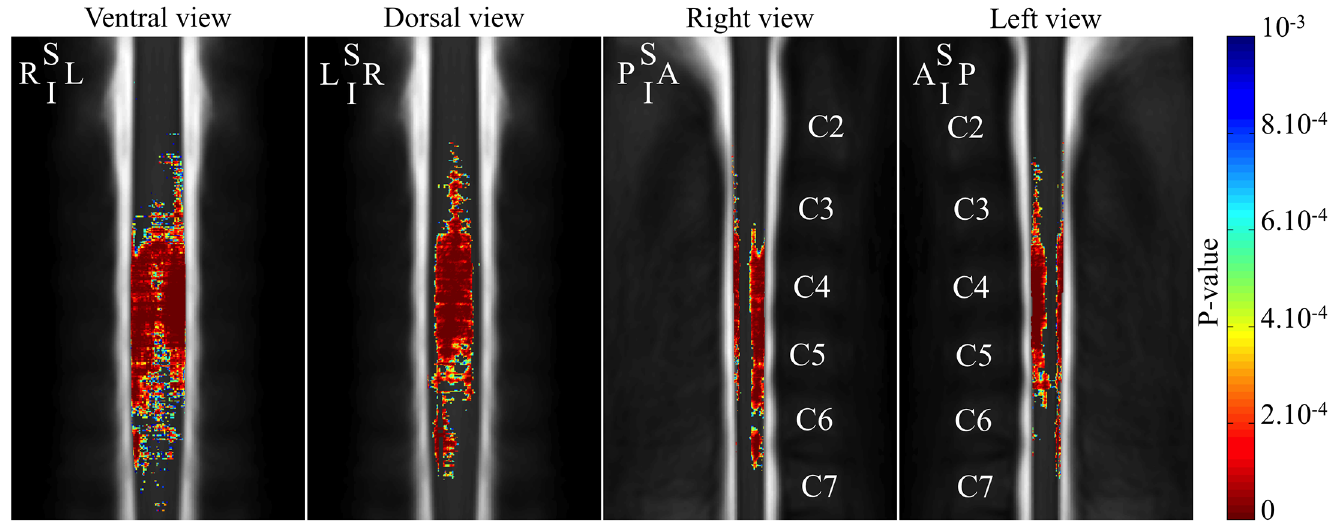
Fig 2. 3D atrophy profile along the cervical spinal cord in SMA patients. The color-coding indicates regions with significant atrophy (color scale = p- values of the between groups comparison). A, anterior; I, inferior; L, left, P, posterior, R, right, S, superior.